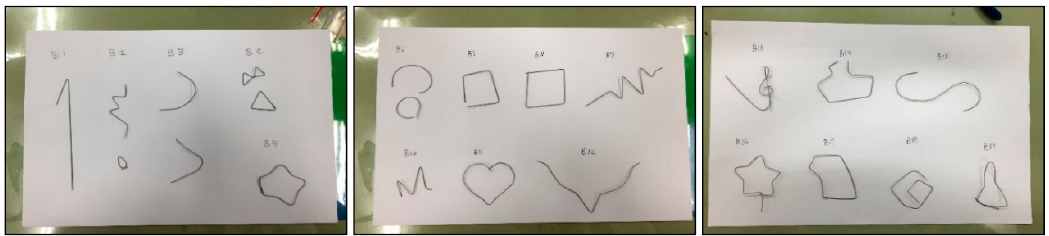
Figure 18. Different shapes of SMA wire folded by the control group.